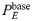
Long-range coupling strength C and background drive PEbase modulate network phase-coherence and relationships between structural and functional connectivity at baseline.(A) The global order parameter ρglobal
vs. PEbase-PE*(C), for different fixed values of C. Error bars are estimated from 100 bootstrap samples of the simulations at each coupling and background drive, and correspond to ± one standard deviation of the bootstrap disribution of ρglobal. (B) The difference between the global and local order parameters, ρglobal − ρlocal, vs. PEbase-PE*(C), for different fixed values of C. Error bars are estimated from 100 bootstrap samples of the simulations at each coupling and background drive, and correspond to ± one standard deviation of the bootstrap distribution of ρglobal − ρlocal. (C) Region-by-region PLV matrices for various values of PEbase-PE*(C) at fixed C = 2.5. The boxed matrices correspond to the red, orange, and yellow working points in Fig 2 and in panels A and B of this figure. (D) The Spearman correlation rs between structural node strength sstruc and functional node strength sfunc
vs. PEbase-PE* at fixed C = 2.5. Empty circles indicate that the correlation was not statistically significant at the p = 0.05 level. The arrows mark three different working points—WP1, WP2, and WP3 (which correspond to the red, orange, and yellow dots/boxes in this figure)—that will be studied in detail.